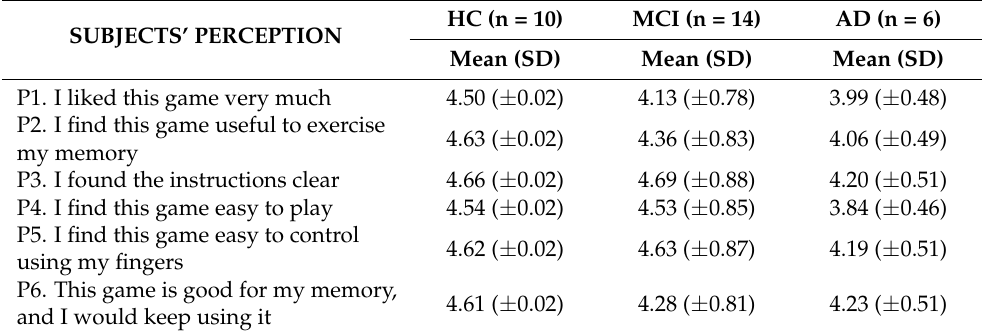
Table 5. Participants’ perception about